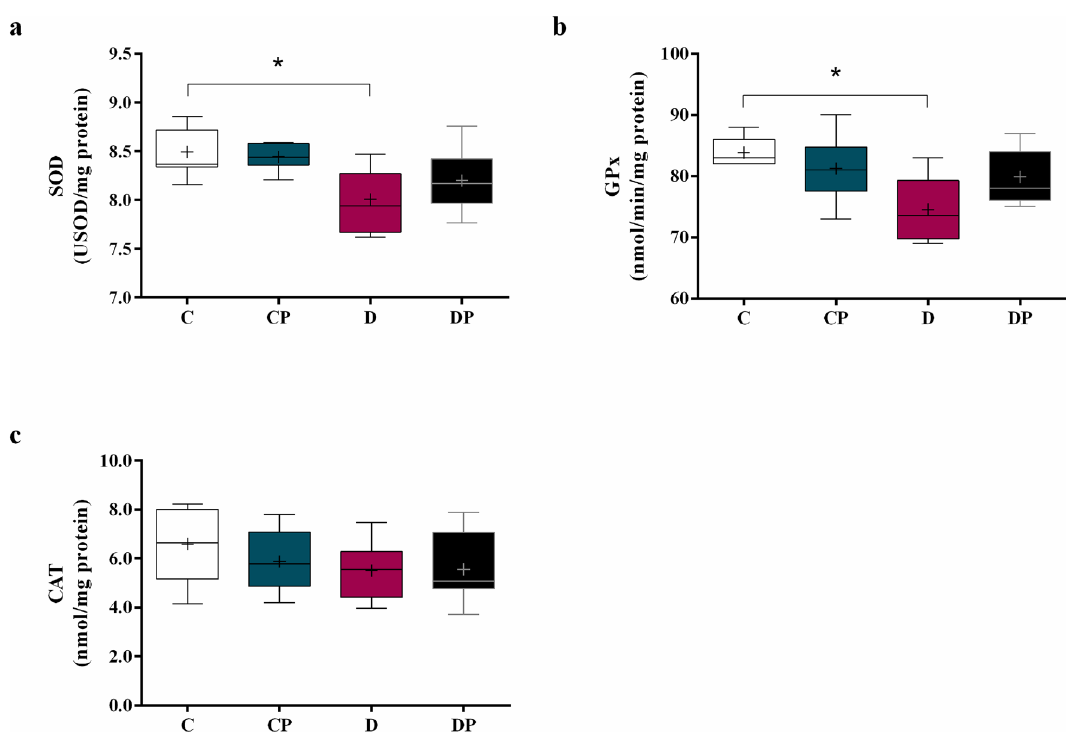
Figure 8. Activity of (a) superoxide dismutase (SOD), (b) glutathione peroxidase (GPx) and (c) catalase (CAT) in hepatic tissue of control (C), control + probiotic (CP), diabetic (D) and diabetic + probiotic (DP) groups (n = 6–9/group). Data are from C57BL/6 STZ-induced diabetic mice, + /- Saccharomyces boulardii (0.5 × 10 8 colony-forming units, THT 500,101 strain , Probiotics and Starters Cultures, Belgium) for 8 weeks. A horizontal line inside the box indicates the median value of the samples within each group, and the upper and lower edges of the box indicate the quartiles. For (a) significance was determined by Two-way ANOVA followed by Tukey’s test. For (b, c) results were evaluated with Kruskal–Wallis, followed by Dunn’s test. + indicates mean value (GraphPad Prism 6). * p ≤